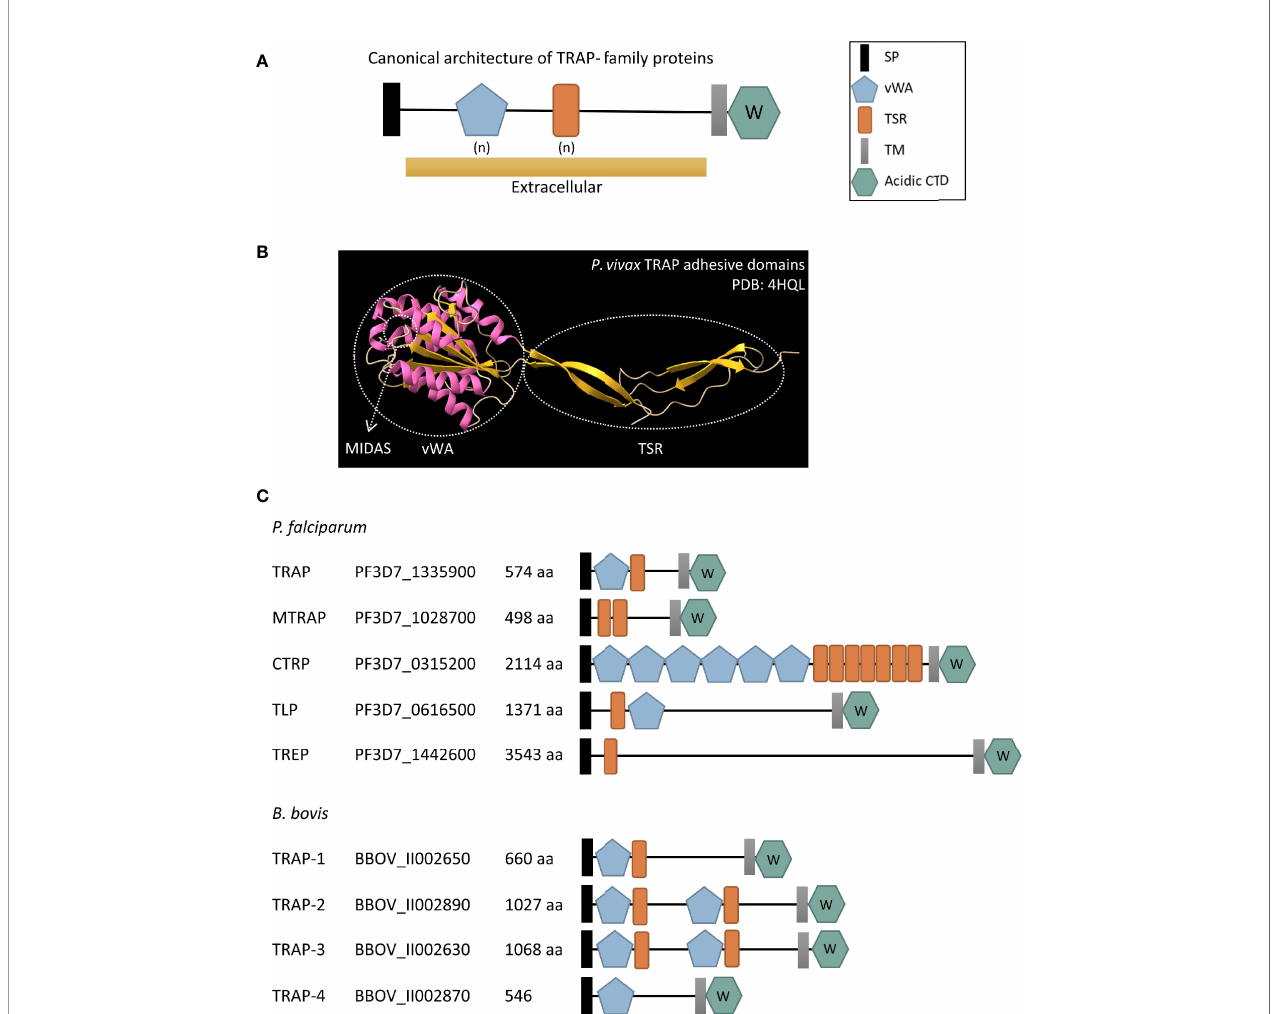
FIGURE 2 | (A) Schematic representation of the canonical architecture of TRAP- family proteins. (B) Cartoon diagram of the crystal structure of the adhesive domains of Plasmodium vivax TRAP protein (PDB: 4HQL). a -helixes are shown in pink while b -strands are shown in yellow. The vWA and TSR domains are indicated in circles and an arrow shows the MIDAS site. (C) Schematic representation of TRAP- family proteins in P. falciparum and B. bovis , two relevant species from Haemosporida and Piroplasmida, respectively. SP, signal peptide; vWA, von Willebrand factor type A domain; TSR, thrombospondin type 1 repeat domain; TM, transmembrane domain; acidic CTD, acidic cytoplasmatic tail domain; aa, number of amino acids in the protein. (n) denotes a variable number of vWA and TSR extracellular domains. The W inside the acidic CTD hexagon indicates that there is a subterminal W residue within it. The accession number provided corresponds to the VEupathDB database